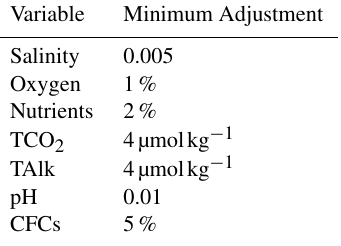
Table 3. Initial minimum adjustment limits. These limits represent the minimum bias that can be confidently established relative to the measurement precision for the variables and cruises considered. Note that these limits are not uncertainties but rather a priori esti- mates of global inter-cruise consistency in the data